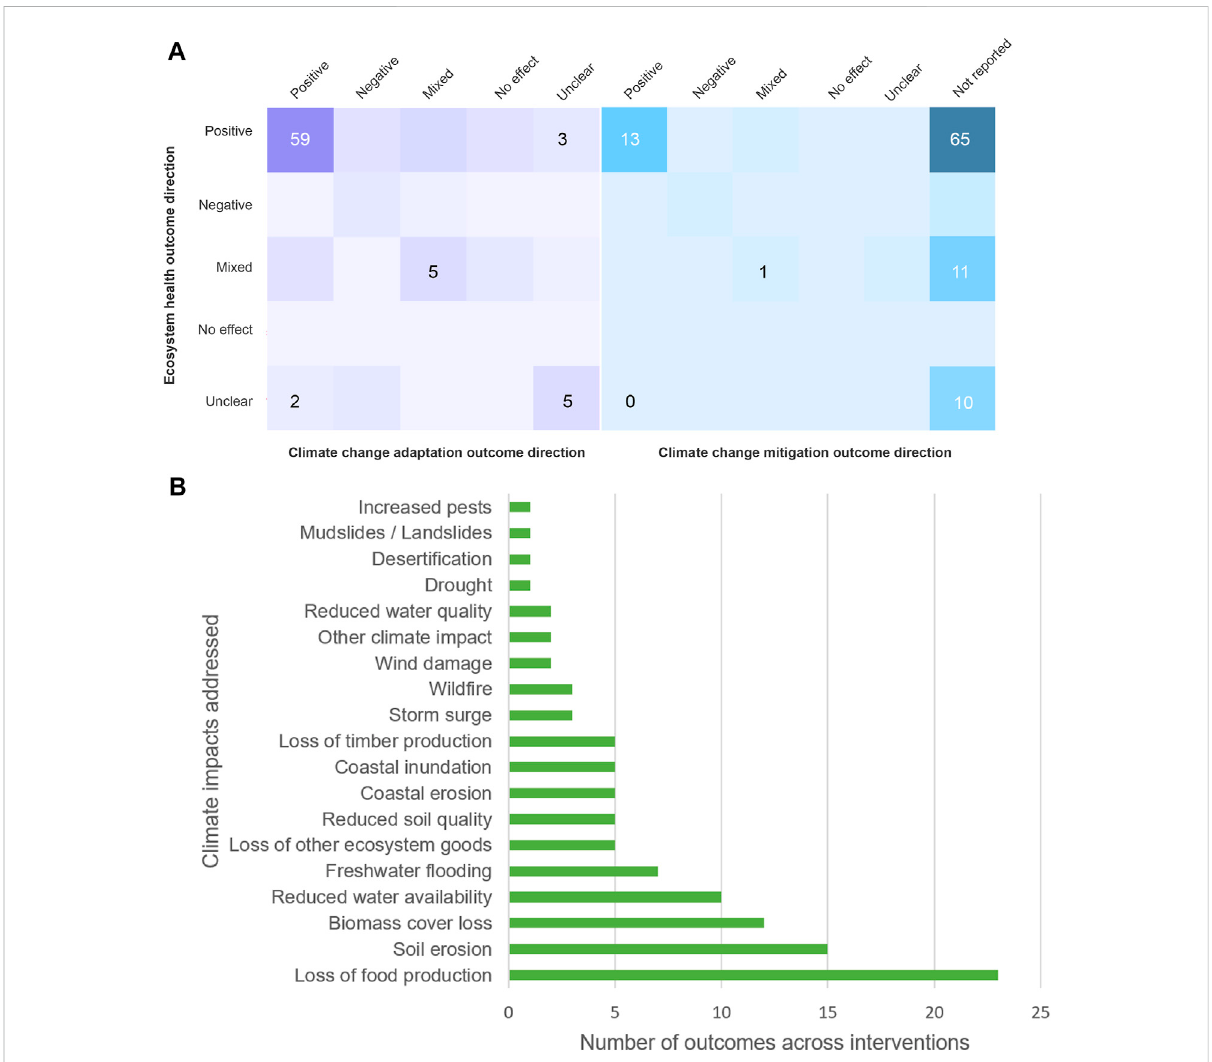
FIGURE 6 Associations between ecosystem health and climate change adaptation and mitigation outcomes across interventions (A) ; climate impacts addressed by interventions with positive outcomes for both ecosystem health and climate change adaptation (108 climate change adaptation outcomes across 79 interventions) (B)